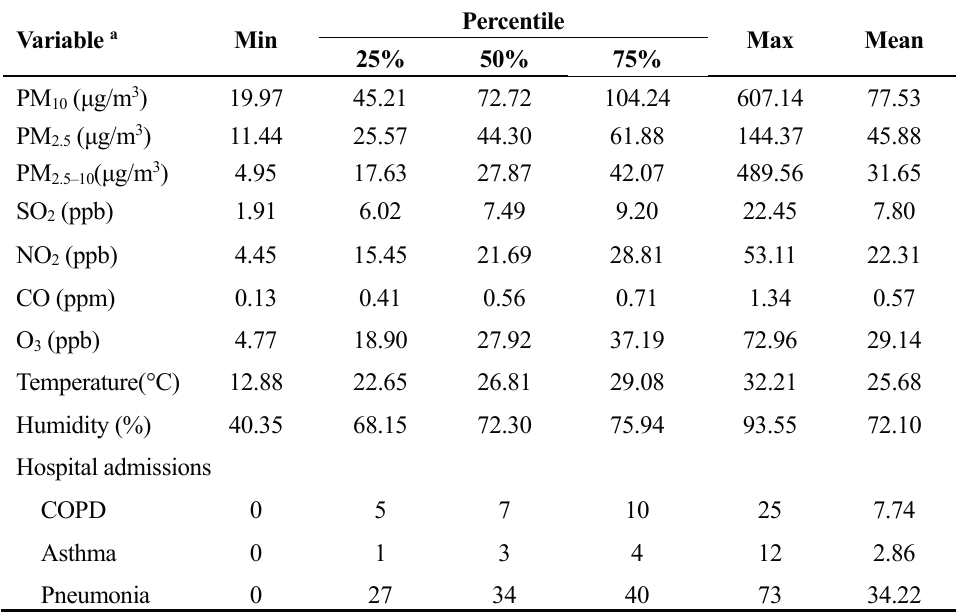
Table 1. Distribution of daily respiratory diseases admissions, weather conditions, and air pollution variables in Kaohsiung, Taiwan, 2006–2010.